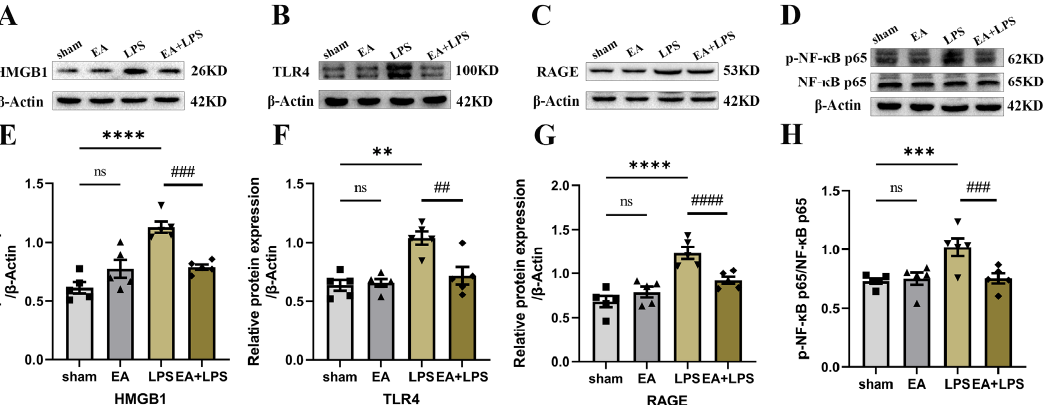
Figure 3. EA modulated HMGB1 signaling in the hippocampus: n = 5 per group. ( A ) Representative blots of HMGB1. ( B ) Representative blots of TLR4. ( C ) Representative blots of RAGE. ( D ) Representative blots of p-NF- κ B p65 and NF- κ B p65. ( E ) Quantification of the expression level of HMGB1. ( F ) Quantification of the expression level of TLR4. ( G ) Quantification of the expression level of RAGE. ( H ) Quantification of the ratio of p-NF- κ B p65 and NF- κ B p65. Data are presented as means ± SEM. Compared with the sham group, ** p < 0.01, *** p < 0.001, and **** p < 0.0001; compared with the LPS group, ## p < 0.01, ### p < 0.001, and #### p < 0.0001. , , , : Represents the individual value of the rats in each group. Abbreviations: HMGB1, high mobility group box 1 protein; NF- κ B, nuclear factor- κ B; p- NF- κ B, phosphorylated-NF- κ B; RAGE, the receptor for advanced glycation end products; TLR4, Toll-like receptor 4; EA, electroacupuncture; LPS: lipopolysaccharide; ns: no significant difference.